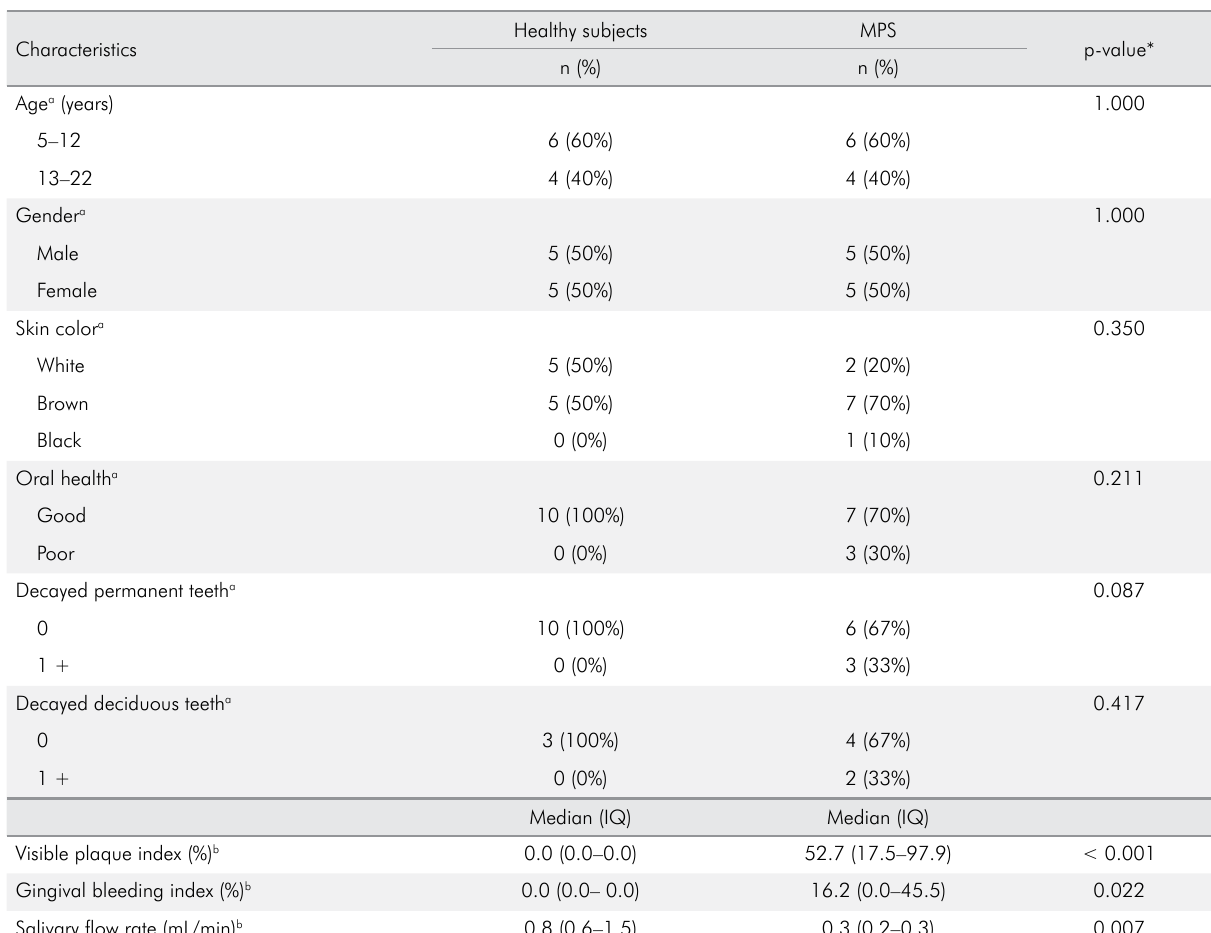
Table 1. Patients